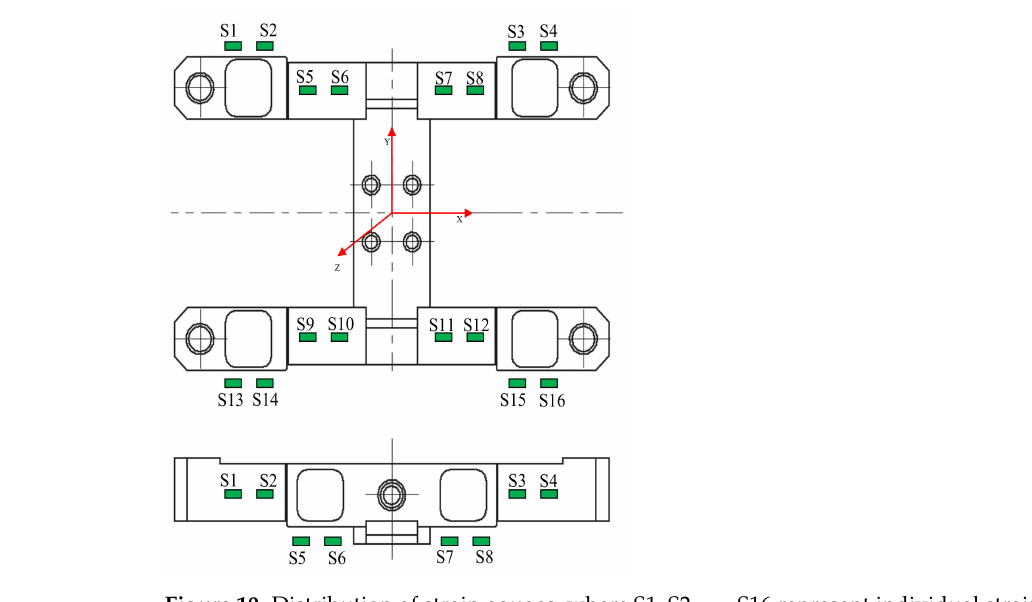
Figure 10. Distribution of strain gauges, where S1, S2, . . . S16 represent individual strain gauges.